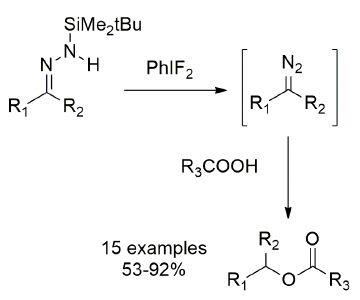
Figure 34- Alternative route for dehydrogenation of hydrazones.